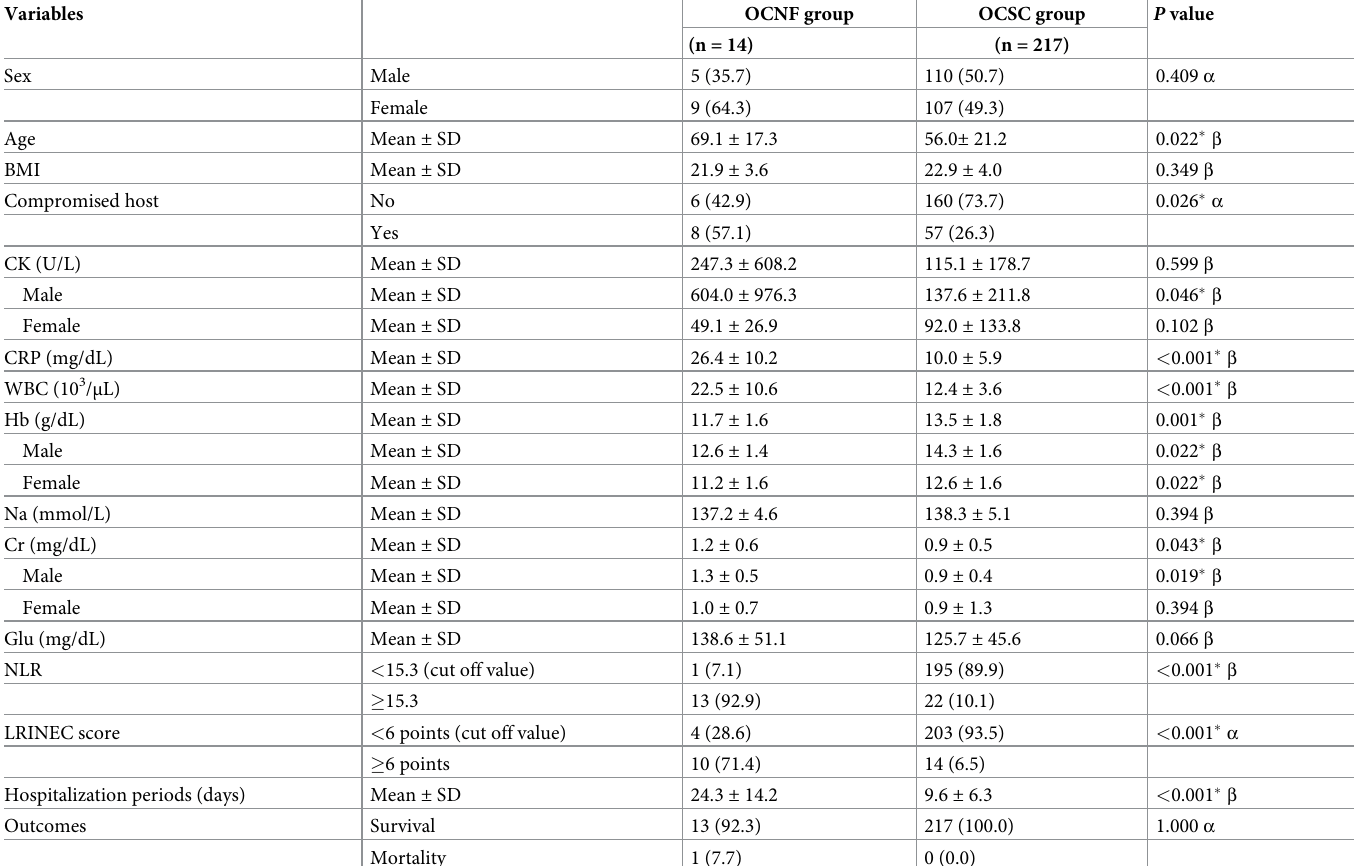
Table 3. Results of univariate analysis of the risk factors for OCNF in OCSI patients. Variables